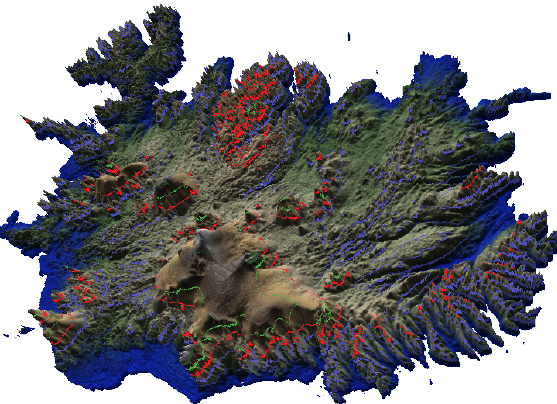
Figure 12. Implicit curves render with 3D surface simulation performed on the Fig. 11a scalar heightmap.